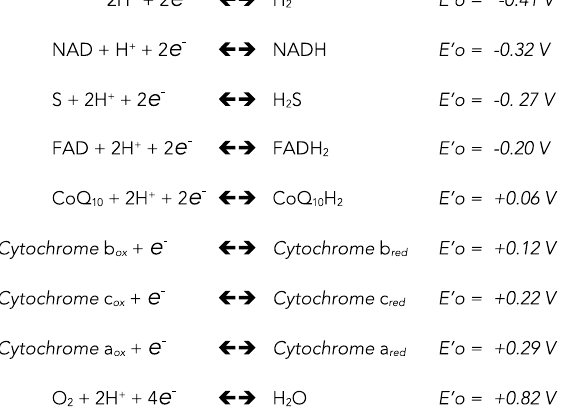
Figure 1. Apparent standard reduction potentials. Sulfur in the native state is in the zero-oxidation state (S 0 ); native sulfur is mostly found with eight atoms linked together forming a ring (octasulfur, S 8 ). In H 2 S (sulfide), the oxidation state of sulfur is − 2. This same value is considered to apply for the sulfur atom engaged in C-SH bonds, such as those present in cysteine. Sulfur can also associate with atoms attracting more vigorous electrons than it does, such as oxygen. Oxidation of sulfur by dioxygen leads to SO 2 (a gas); its reaction with water forms sulfurous acid (H 2 SO 3 ) that dissociates into protons and a sulfite ion, SO 32 − . The oxidation state of sulfur in sulfite is +4; further oxidation leads to sulfate (SO 42 − ), in which the sulfur oxidation state